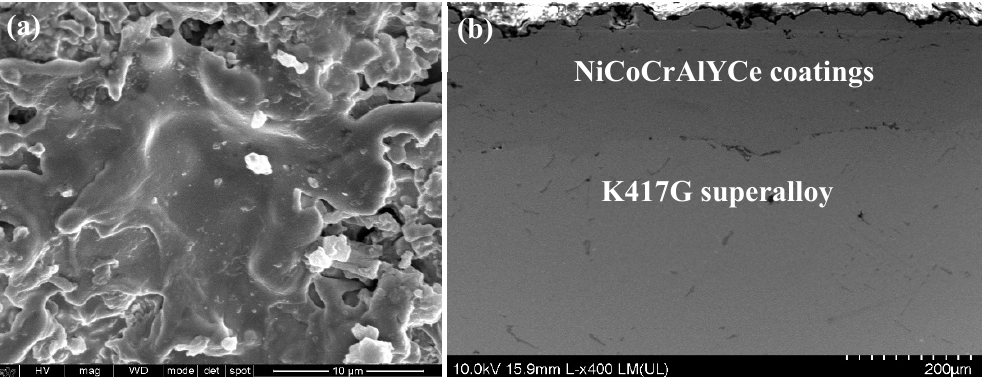
Figure 2. Surface ( a ) and cross section ( b ) images of as-sprayed NiCoCrAlYCe coatings.